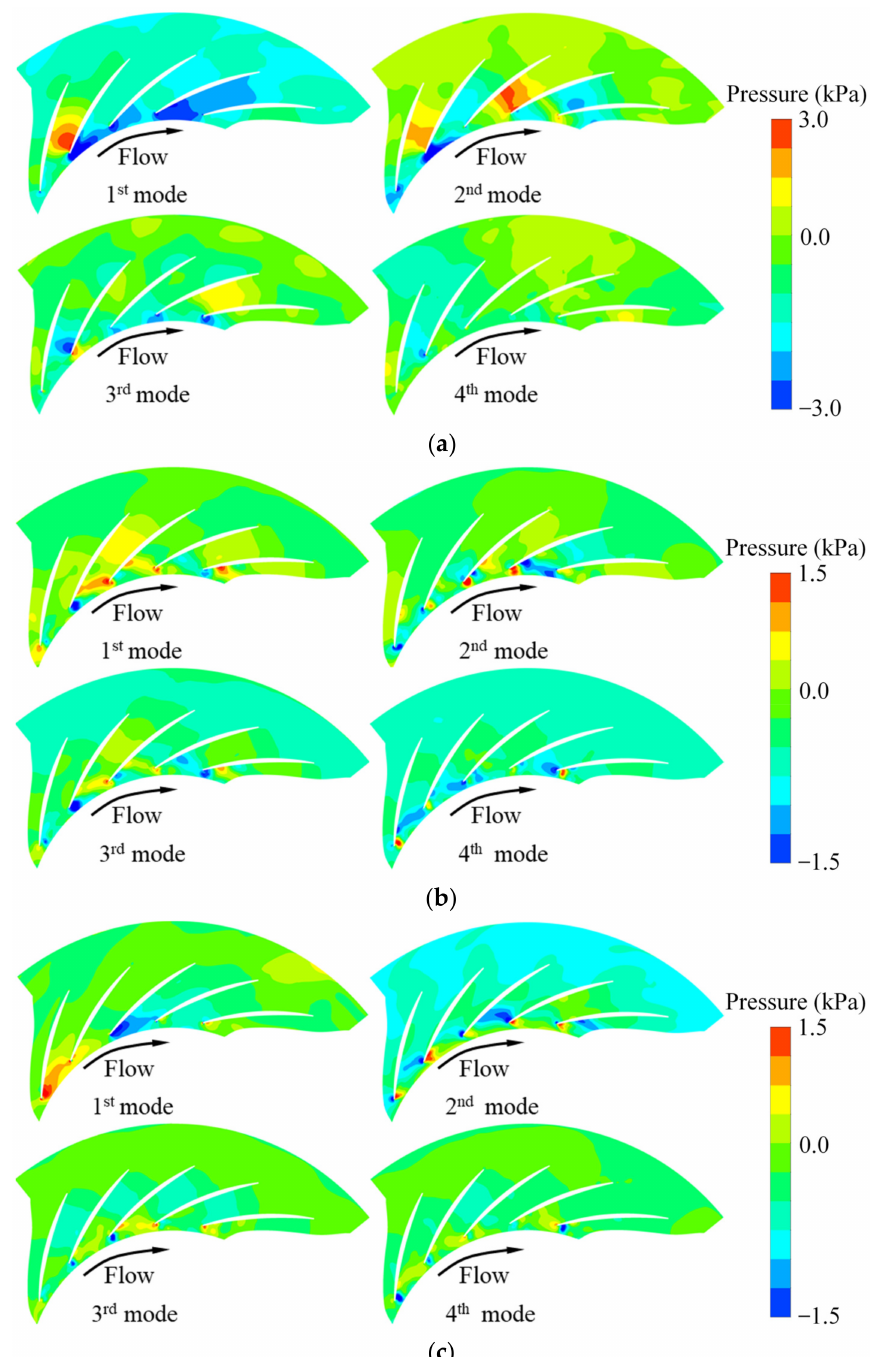
Figure 16. Spatial distribution of the pressure field for the first four POD eigenmodes in the diffuser (97% span, ϕ = 0.0833): ( a ) IGV30, ( b ) IGV45, ( c )